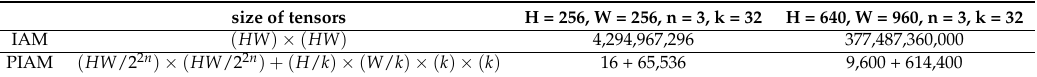
Figure 4. Illustration of pyramid inter-attention module (PIAM). The global IAM first finds global correspondences using discriminative down-sampled features the first level feature F l o toward the reference domain r , the local IAM finds local correspondences using (cid:111) (cid:110) F l r , F (cid:48) l o at a fine level. Finally, we can warp the feature E o toward E r to generate E (cid:48) o . features Table 1. Total memories of soft inter-attention map to find global correspondence. size of